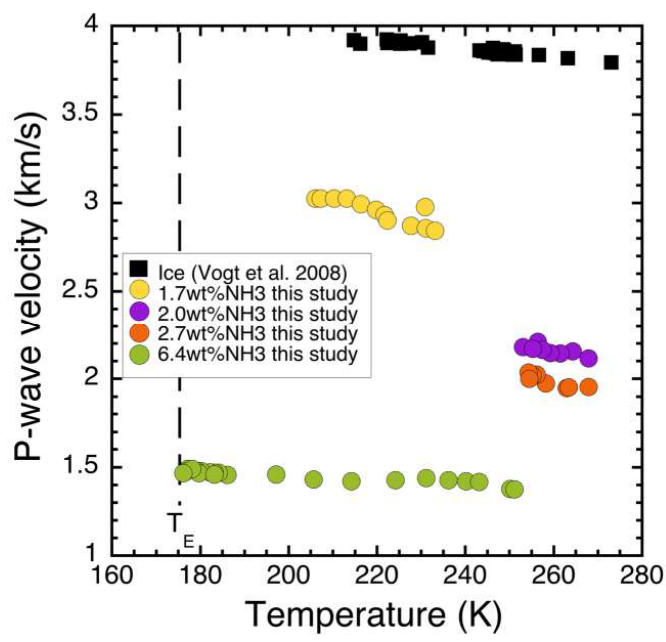
Figure 4. P-wave velocities (at 54 KHz) in ice containing 1.7–6.4 wt % NH 3 as a function of temperature, compared to pure ice [58].